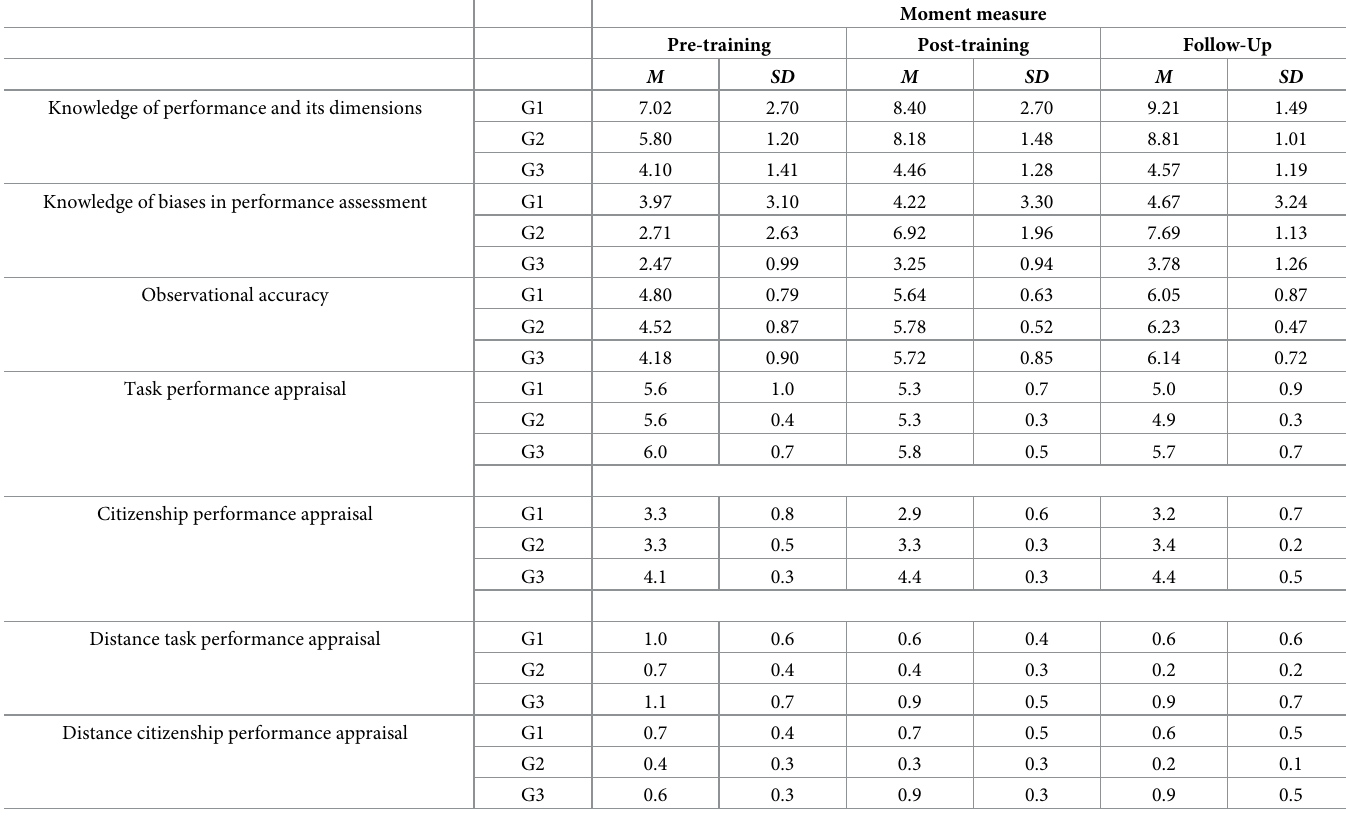
Table 2. Descriptive statistics of the dependent variables in each training group and moment measure